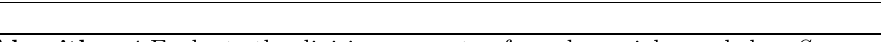
Algorithm 4 Evaluate the division property of a polynomial encoded as S f